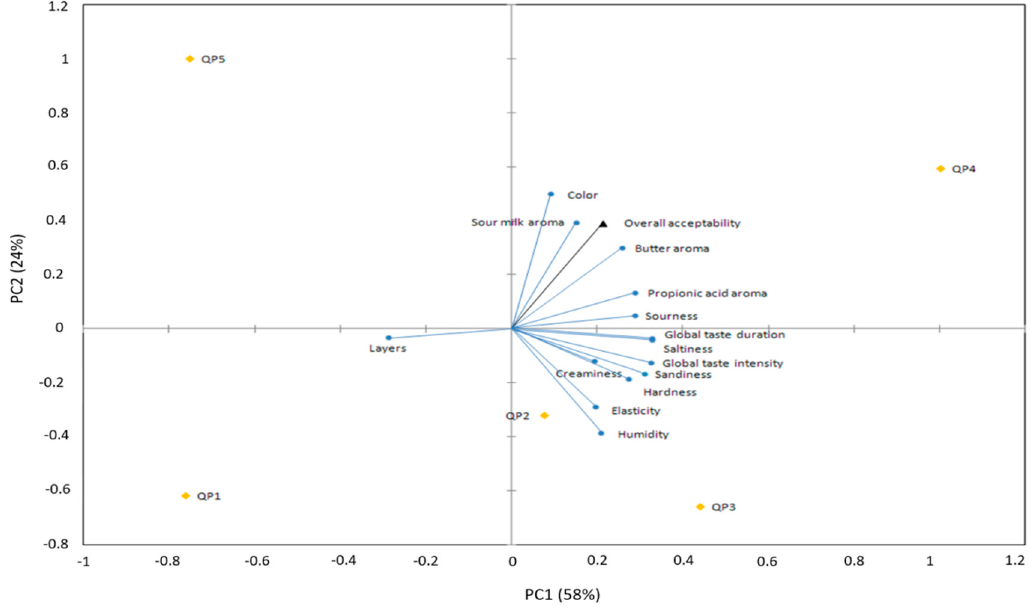
Figure 4. Poro cheese external preference map.